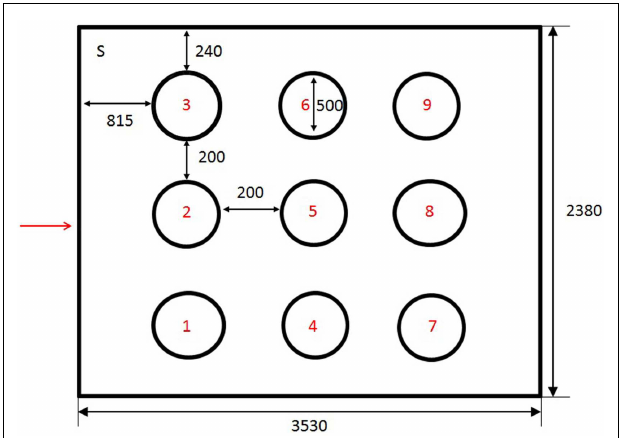
FIGURE 2 | Schematic representation of holeboard arena . Holes were numbered from 1 to 9. Chickens were introduced into the holeboard from the corner of the room marked S.The entrance to the arena is marked with an arrow.The dimension of the test arena was 3530mm × 2380mm. Circles were 240mm from the long wall and 815mm from the short wall. They had a diameter of 500mm and were separated by a 200mm